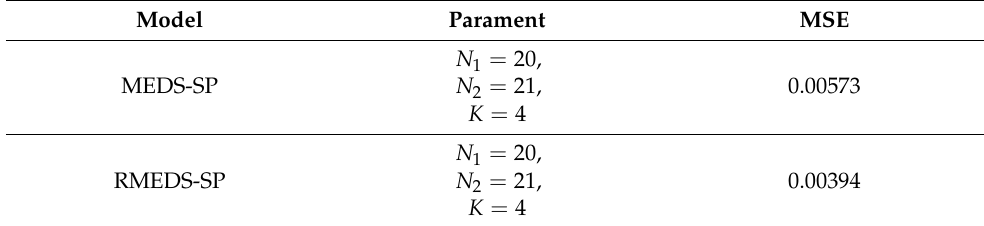
Table 2. MSE of simulation errors of different models.